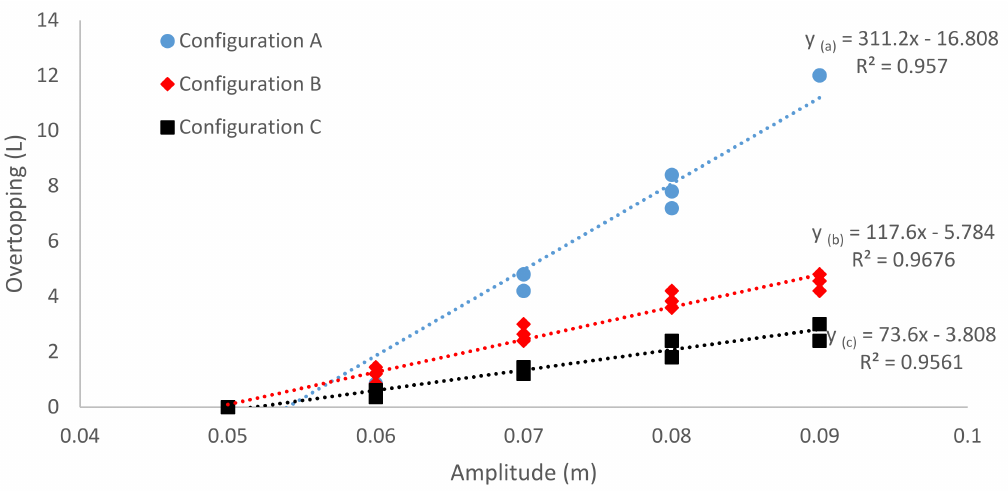
Figure 8. Sine wave hydraulic conditions; overtopping measure vs. amplitude; no slope angle adopted within the experimental facility.